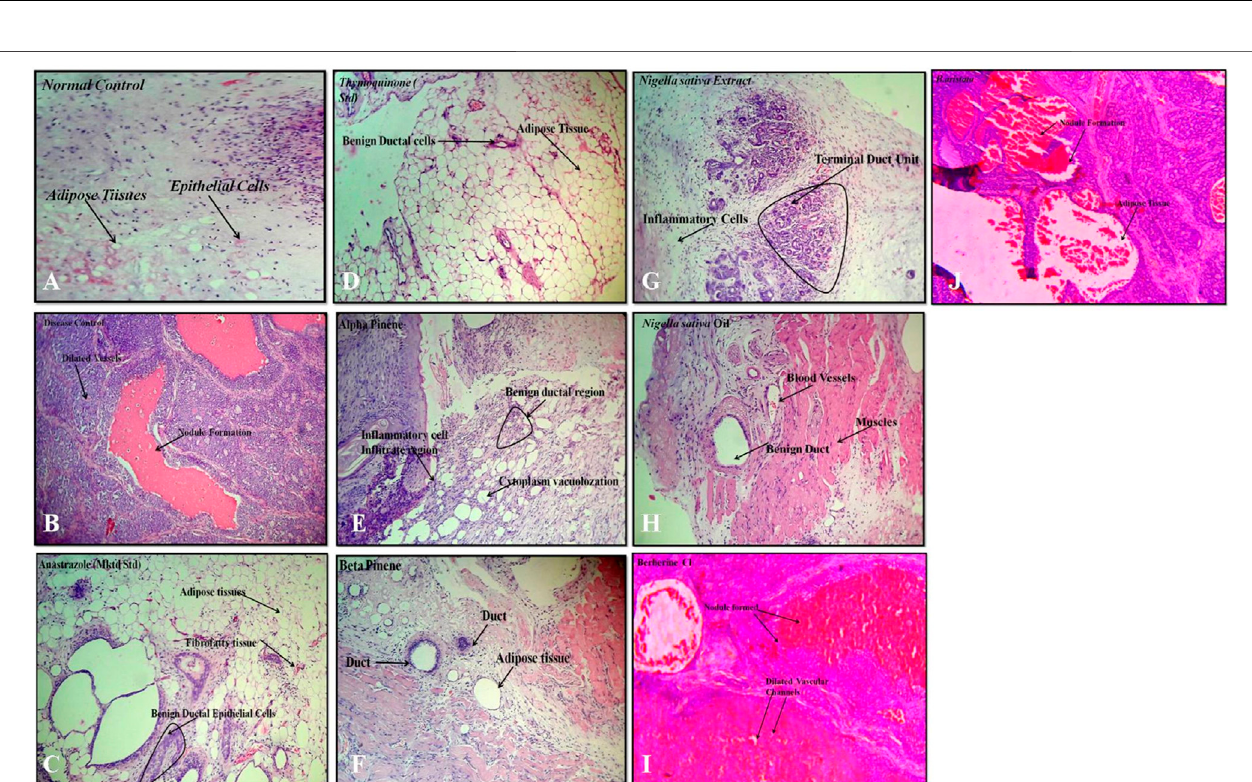
FIGURE 6 | (A – C) Effect of treatments on the Hb count and WBC and RBC count (disease vs treatments